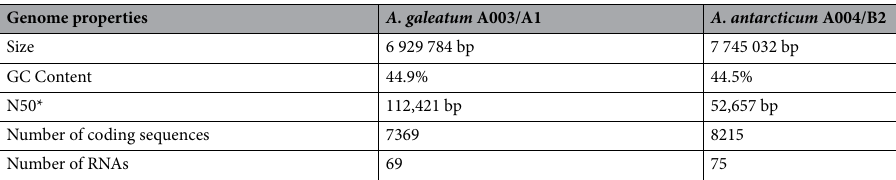
Table 1. Basic genome properties of Argonema galeatum strain A003/A1 and Argonema antarcticum strain A004/B2. *Sequence length of the shortest contig at 50% of the total genome